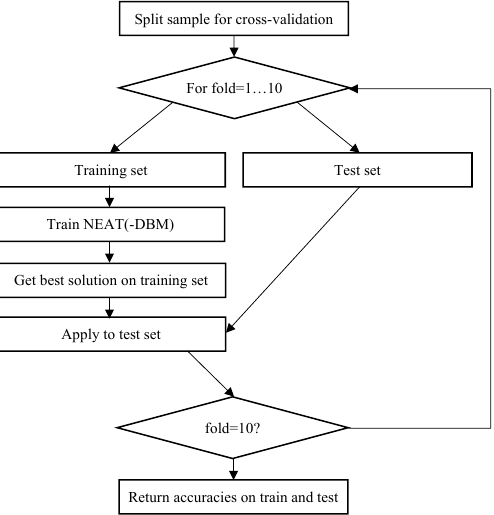
Figure 4. The block scheme of NEAT and NEAT-DBM